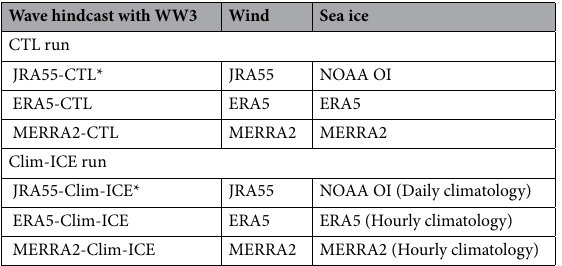
Table 2. Six model simulations based on the WW3. *Note that only JRA55-CTL and JRA55-Clim-ICE runs used the model results from Iwasaki 15